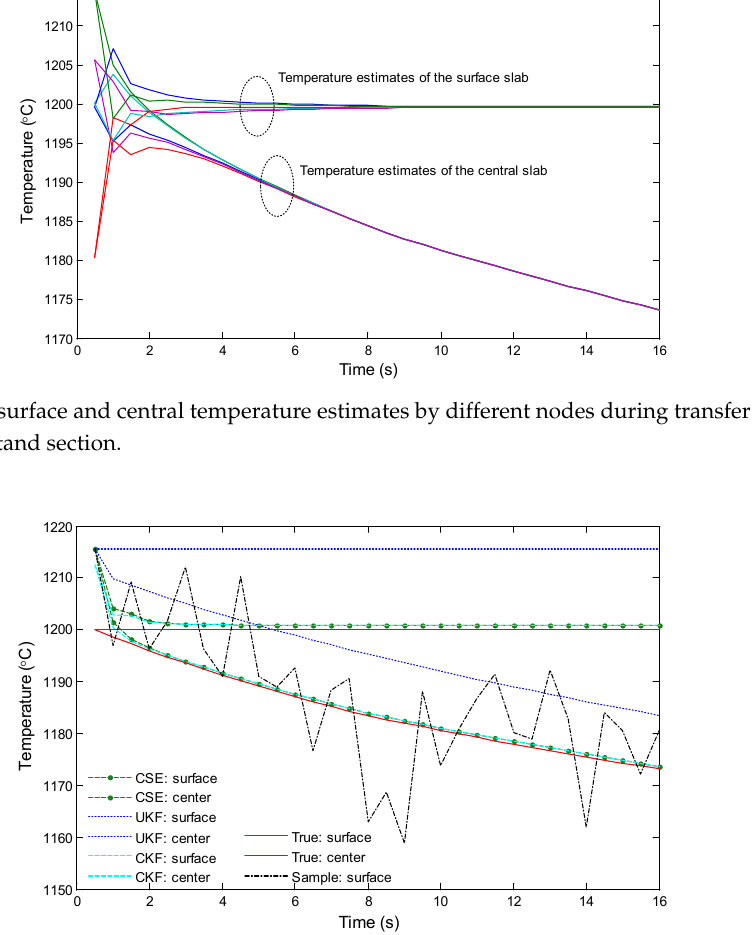
Figure 7. Comparison of the estimated temperatures by CSE, the centralized Kalman Filter (CKF), and the unscented Kalman filter